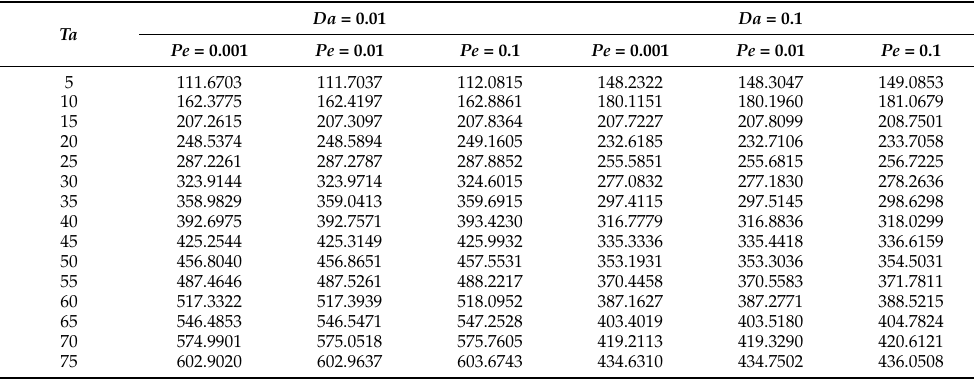
Table 5. Critical Rayleigh number for upward throughflow fixed at Q =